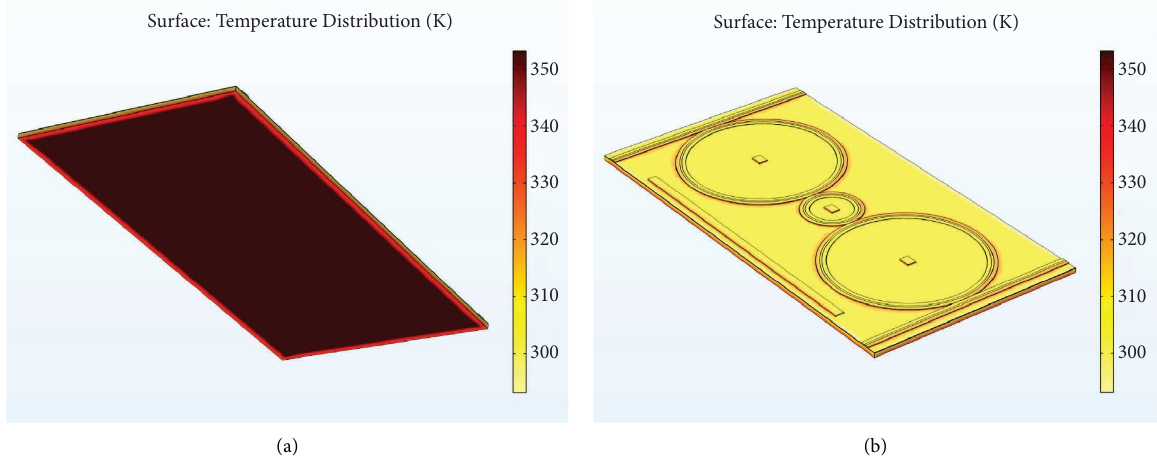
Figure 12: (a) Heat distribution at the bottom of the substrate. (b) 3D view of the heat profle in the structure of the device.